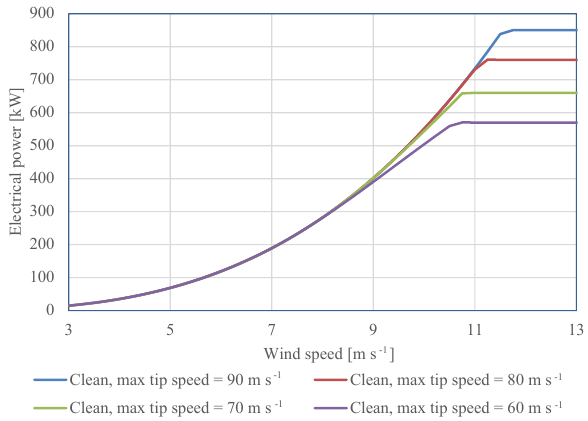
Figure 15. Simulated power curves for the Vestas V52 for different maximum tip